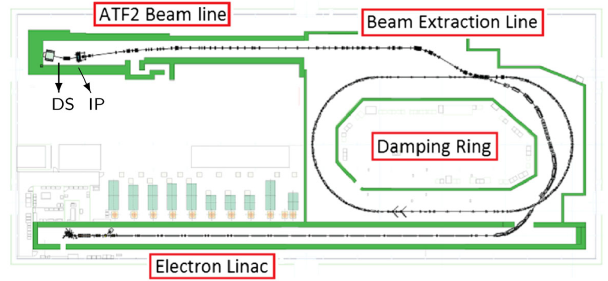
FIG. 1. Schematic diagram of ATF linac, damping ring and ATF2 beam line, from [14].